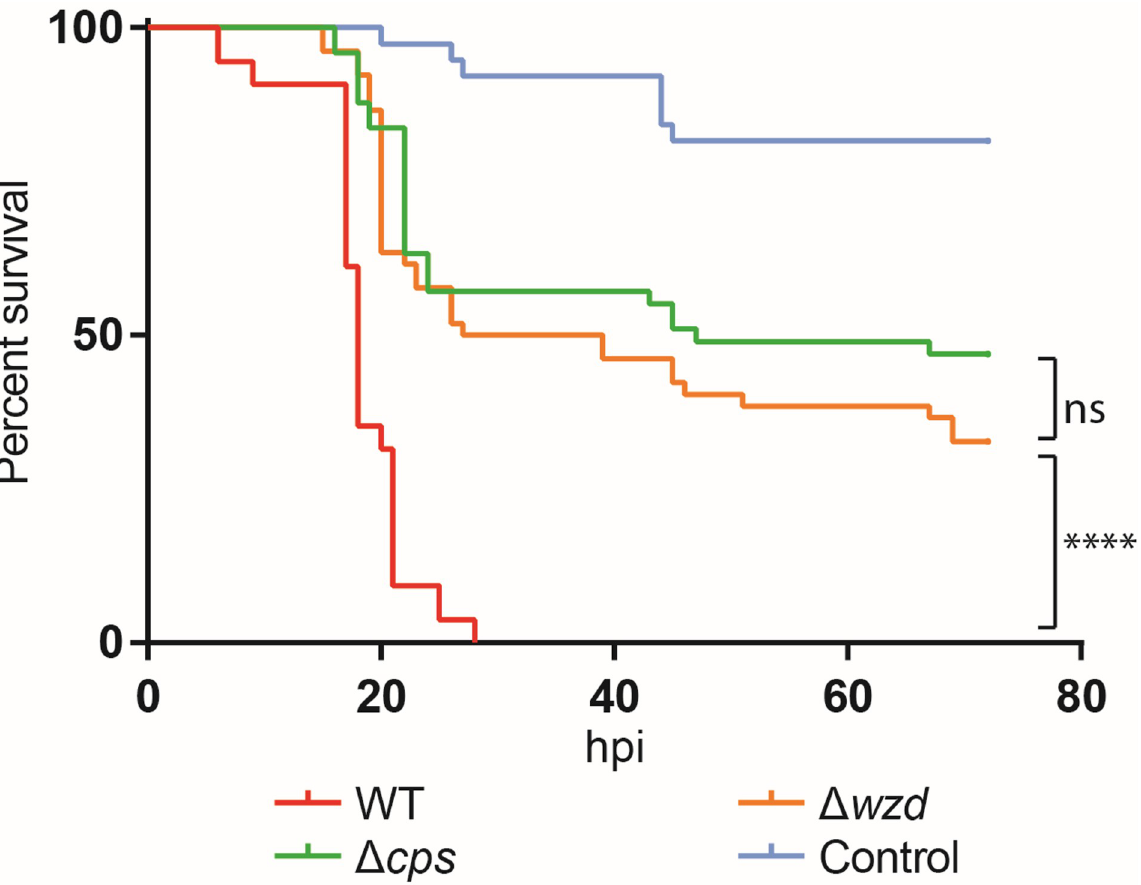
Fig 8. Full encapsulation of the cells is necessary for virulence. A) Survival graph of zebrafish embryos injected, three days post-fertilization, with wild-type ATCC6314 (WT), unencapsulated BCSMC001 ( Δ cps ), wzd null mutant BCSMH001 ( Δ wzd ) and medium used to resuspend bacteria (Control). The wzd null mutant was severely impaired in virulence, similarly to the unencapsulated BCSMC001 strain. The assay was performed with at least 50 embryos for each condition that were injected in four different days and the obtained survival curves, except those obtained with the cps and wzd mutants, were significantly different (p < 0.0001). (hpi) hours post